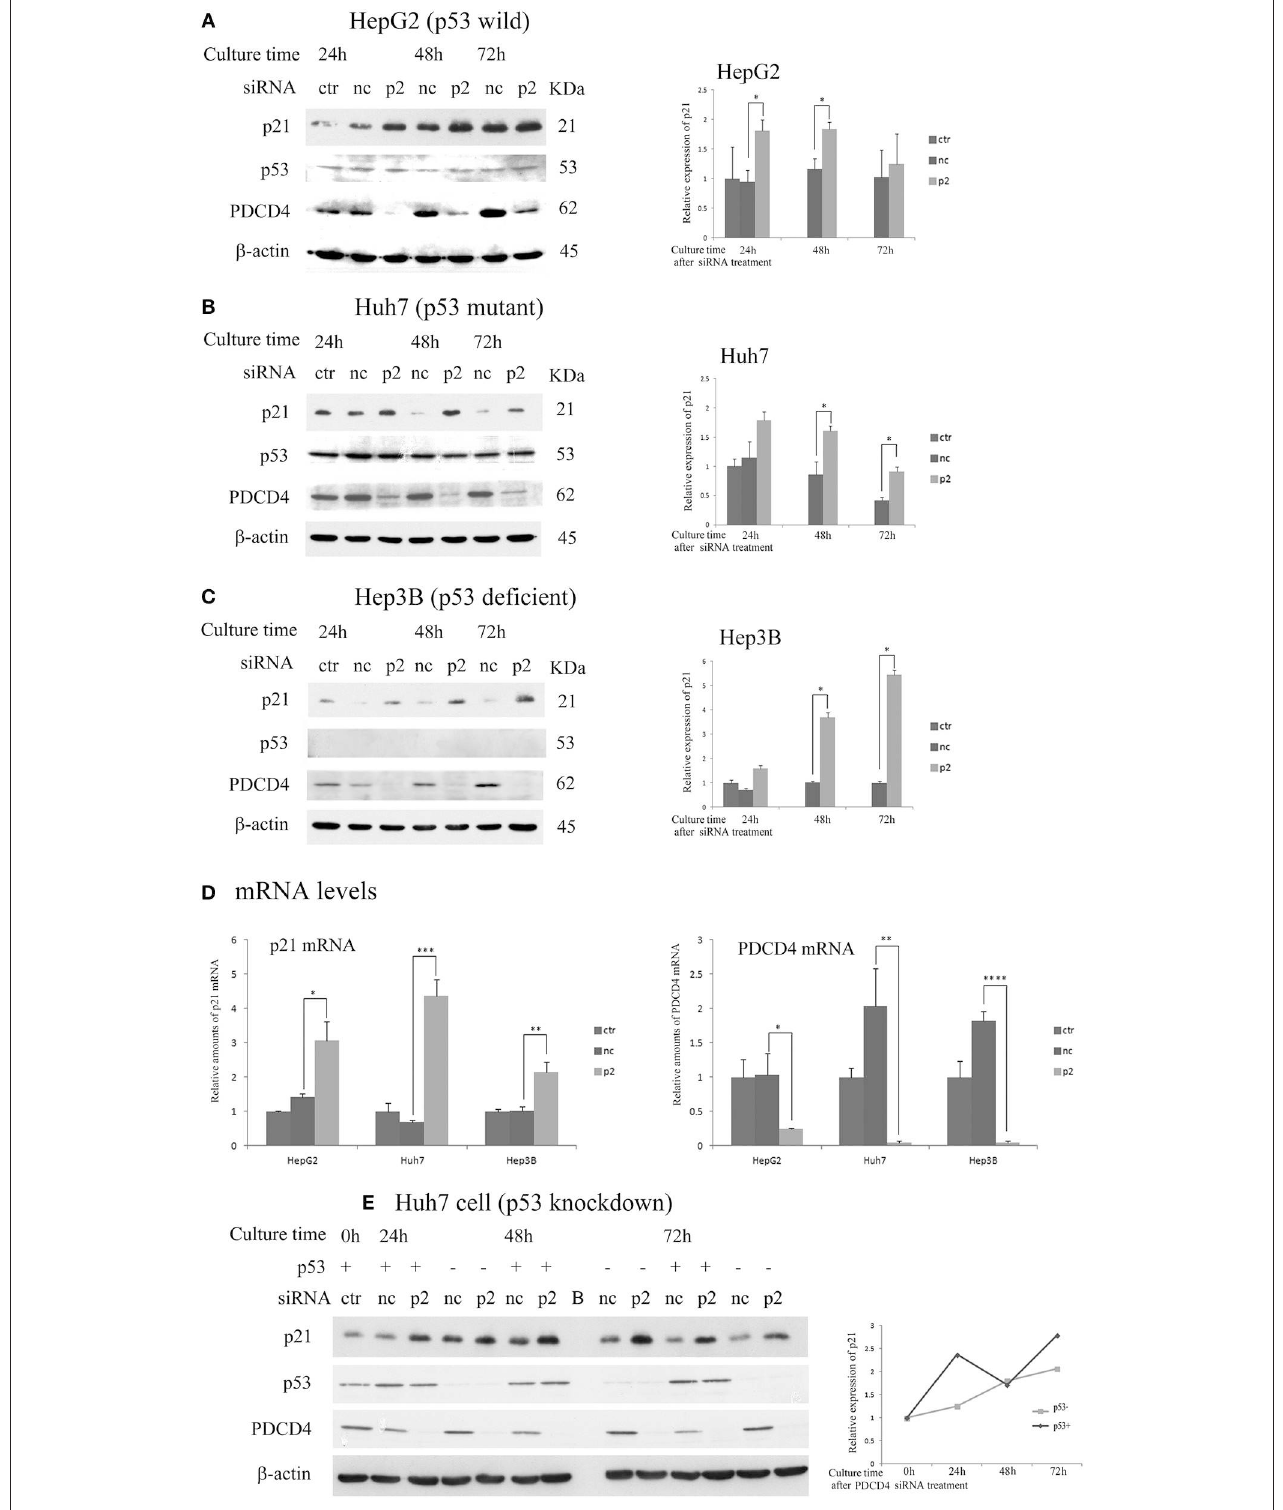
FIGURE 3 | PDCD4 knockdown up-regulated the expression of p21 in HepG2, Huh7, and Hep3B cells . The experiments were performed as in Figure 2 . A Western blot analysis of the untreated cells (ctr), negative control siRNA-treated cells (nc), and p2 siRNA-mediated PDCD4 knockdown cells (p2), were performed using antibodies against p21, p53, PDCD4 and β -actin. (A–C) Western blotting (Left) and a diagram of the relative p21 expression obtained from the Western blot (Right) of